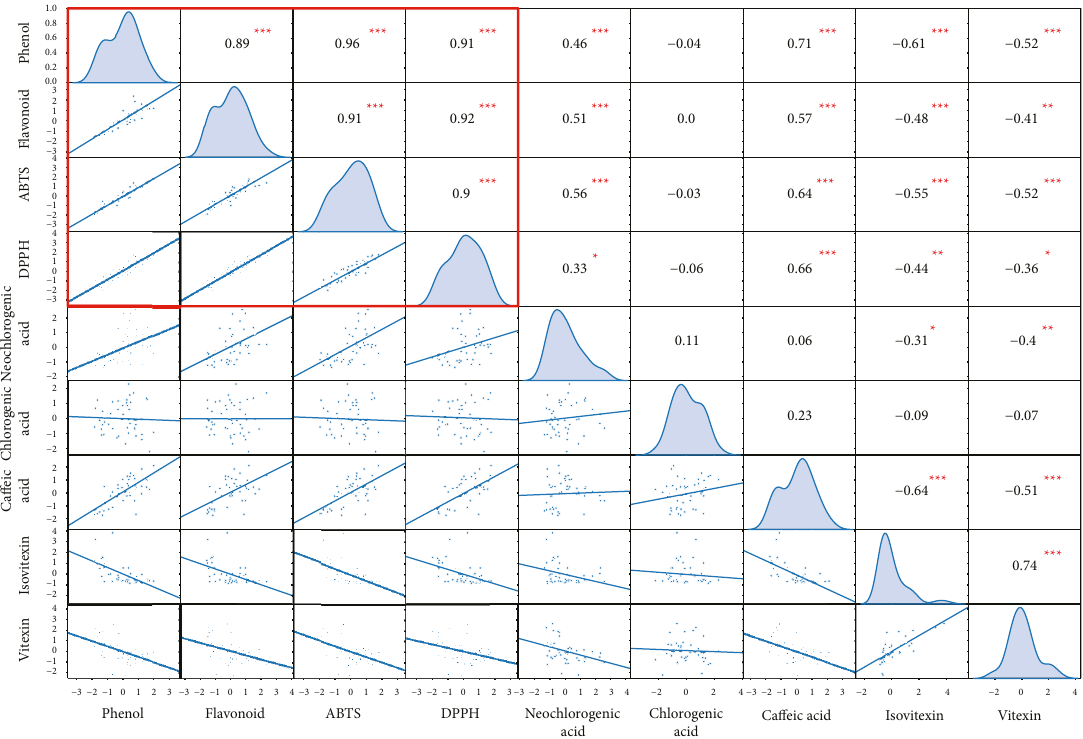
Figure 4: Correlation among four assays (phenol, flavonoid, ABTS, and DPPH) and five metabolites (neochlorogenic acid, chlorogenic acid, caffeic acid, isovitexin, and vitexin). Numeric values in the upper map are the correlation coefficient between two assays, and the stars indicate the statistical significance of the value. The lower map shows a scatter plot with a trend line for the correlation coefficient value, and the diagonal line shows a density plot of the value. Table 2: Two-way analysis of variance